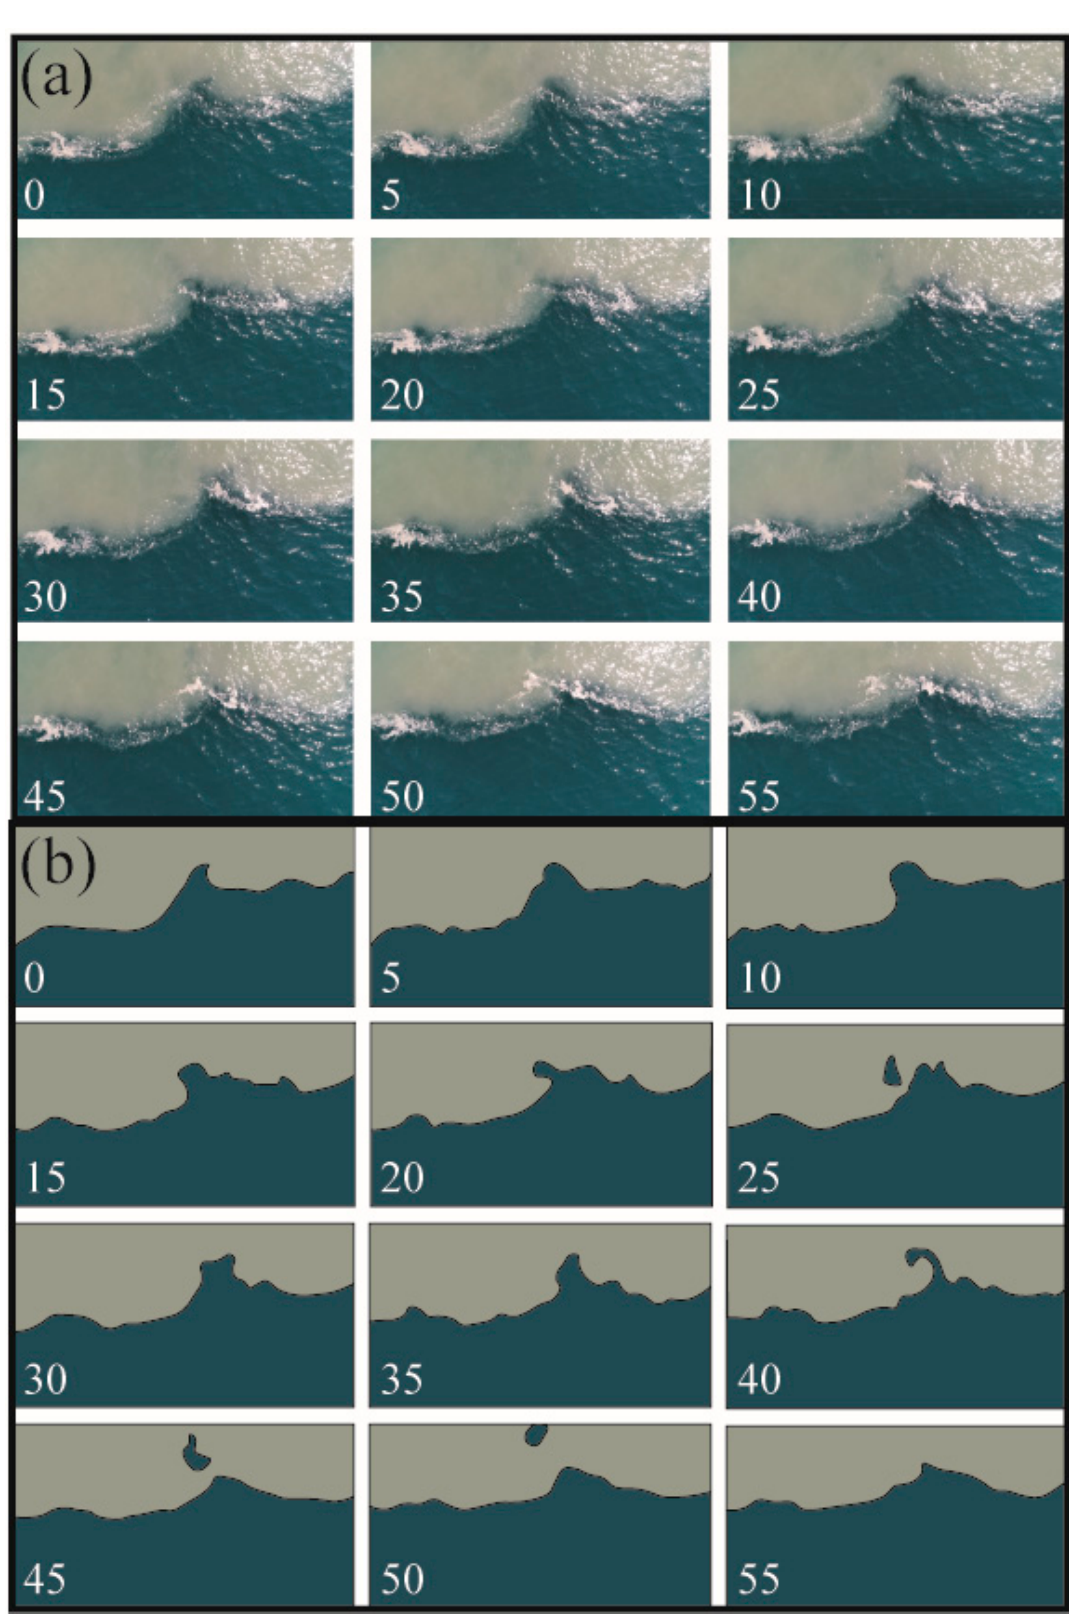
Figure 13. ( a ) aerial images and ( b ) reconstructed shapes of the border of the Kodor plume on 1 September 2018 illustrating merging of lobes and trapping of spots of saline sea. Numbers indicate time intervals in seconds from the beginning of observations.